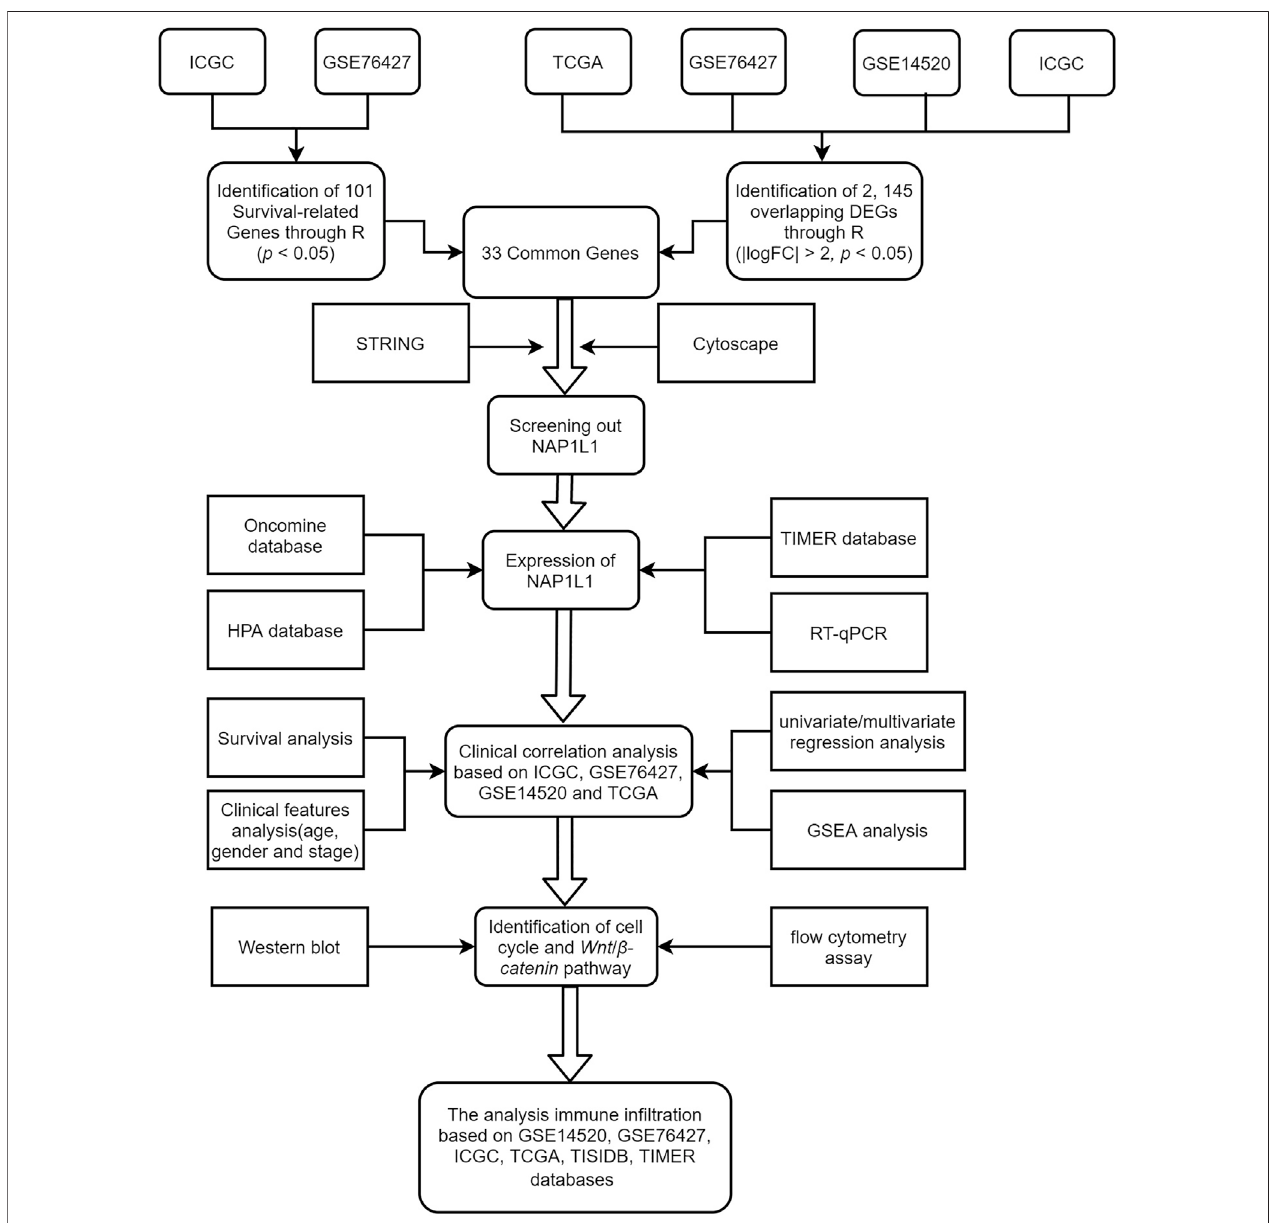
FIGURE 1 | Flow diagram for